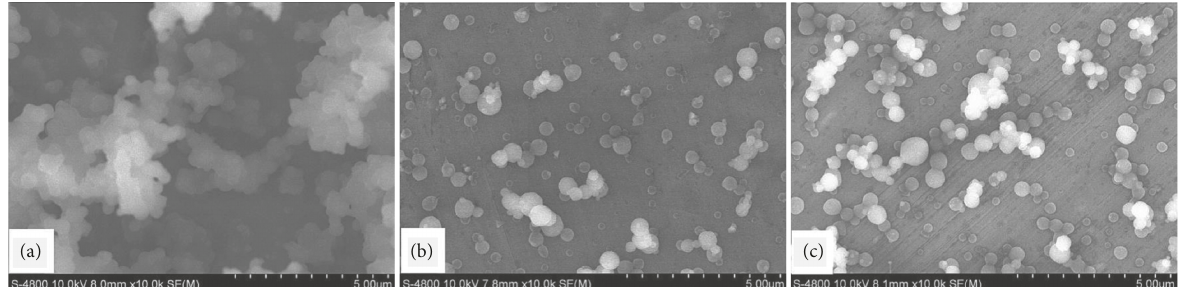
Figure 12: SEM images of 1.5 wt.% M3 chitosan concentration in 90 wt.% acetic acid concentration at a different voltage (U) and distance L. (a) U 9kV and L 7cm; (b) U 12kV and L 10 cm; (c) U 15kV and L 12 (cid:30) (cid:30) (cid:30) (cid:30) (cid:30) (cid:30)